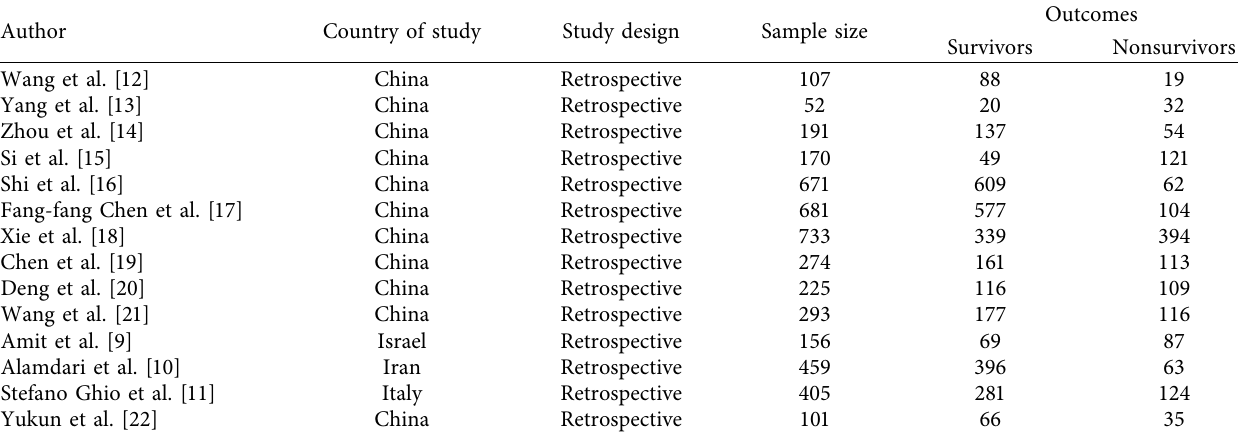
Table 1: Characteristics of included